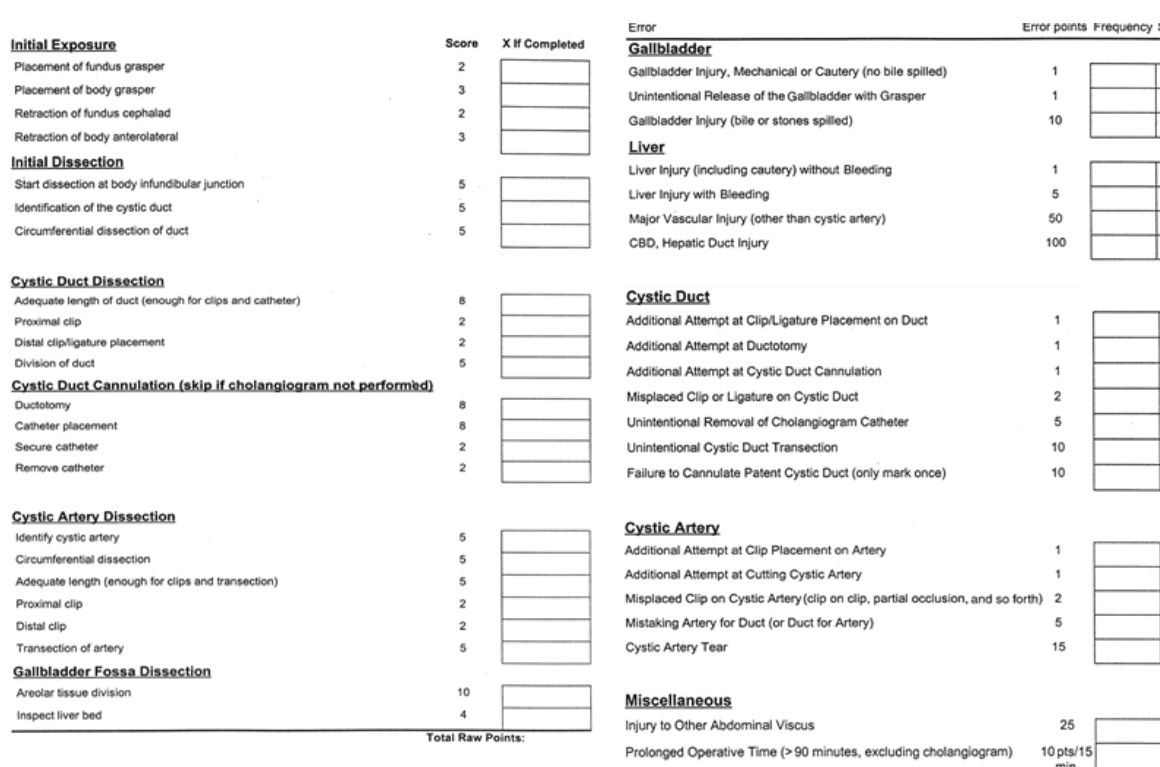
Table 3: Steps and errors in video laparoscopic cholecystectomy. Part 1.16